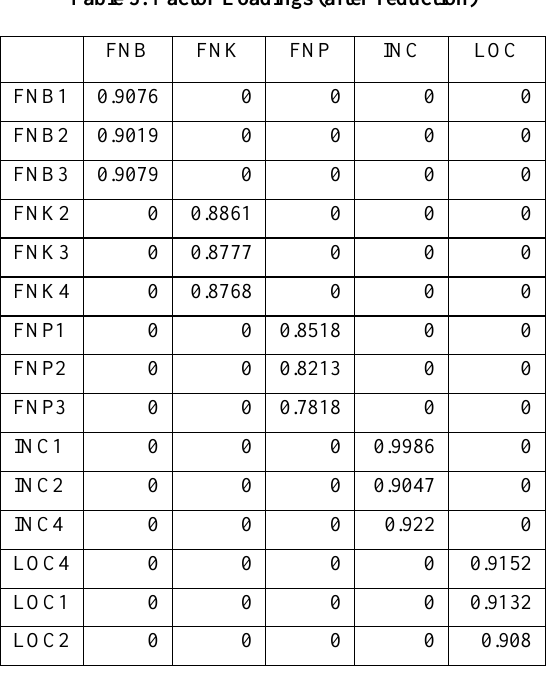
Table 5: Factor Loadings (after reduction)